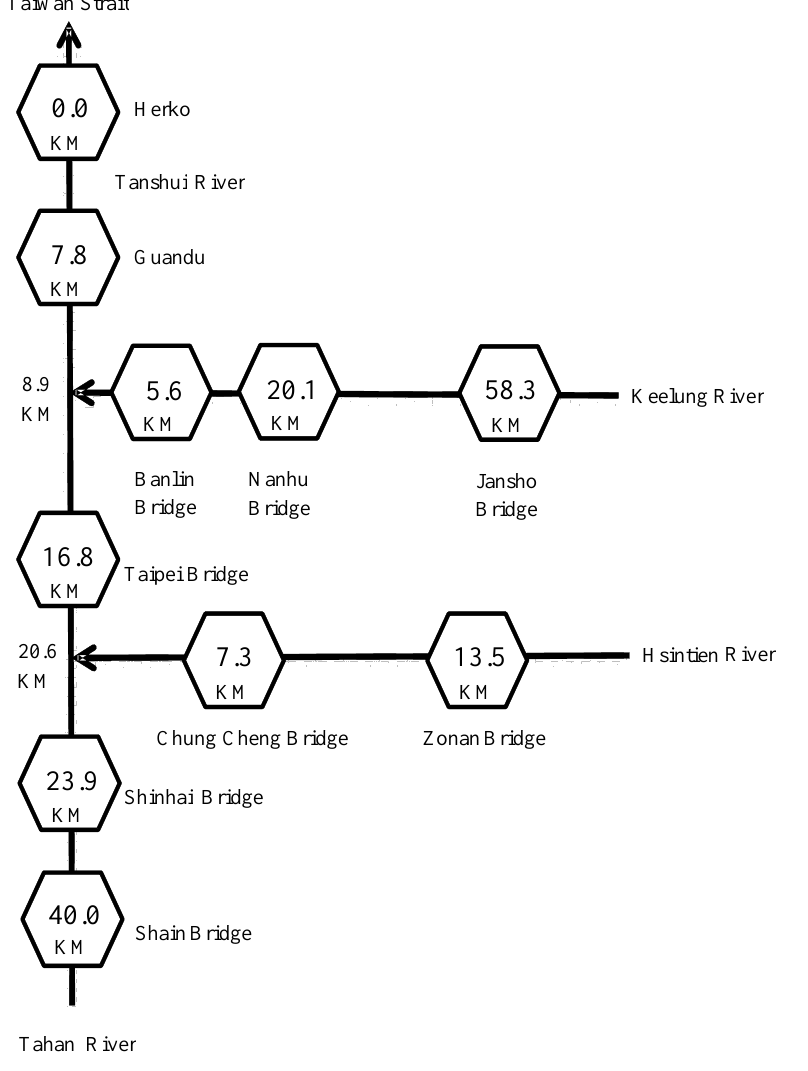
Figure 5. Distances in river kilometers of sampling stations in the catchment of the Tanshui River.